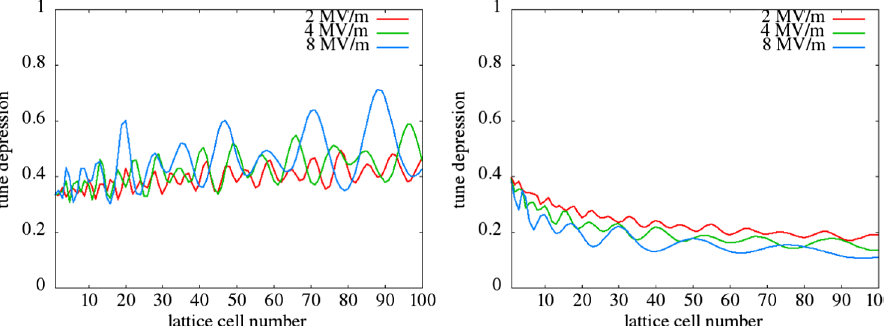
FIG. 14. The horizontal (left) and longitudinal (right) tune depression ratios as a function of lattice cell number in the quadrupole-rf